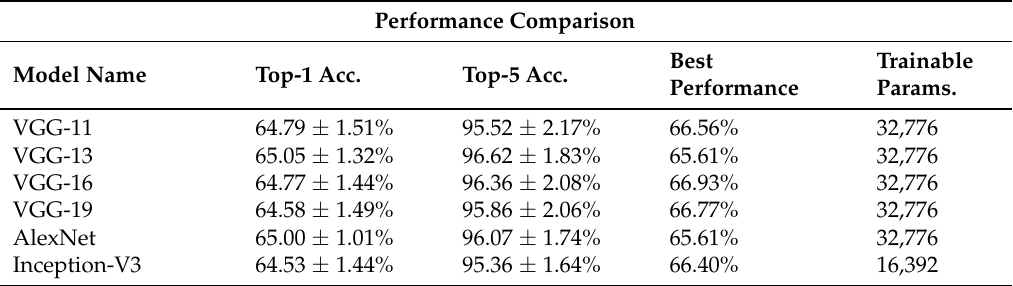
Table 3. Classification results using transfer learning scheme. The pre-trained deep neural networks used are VGG, AlexNet, Inception, ResNet, DenseNet and